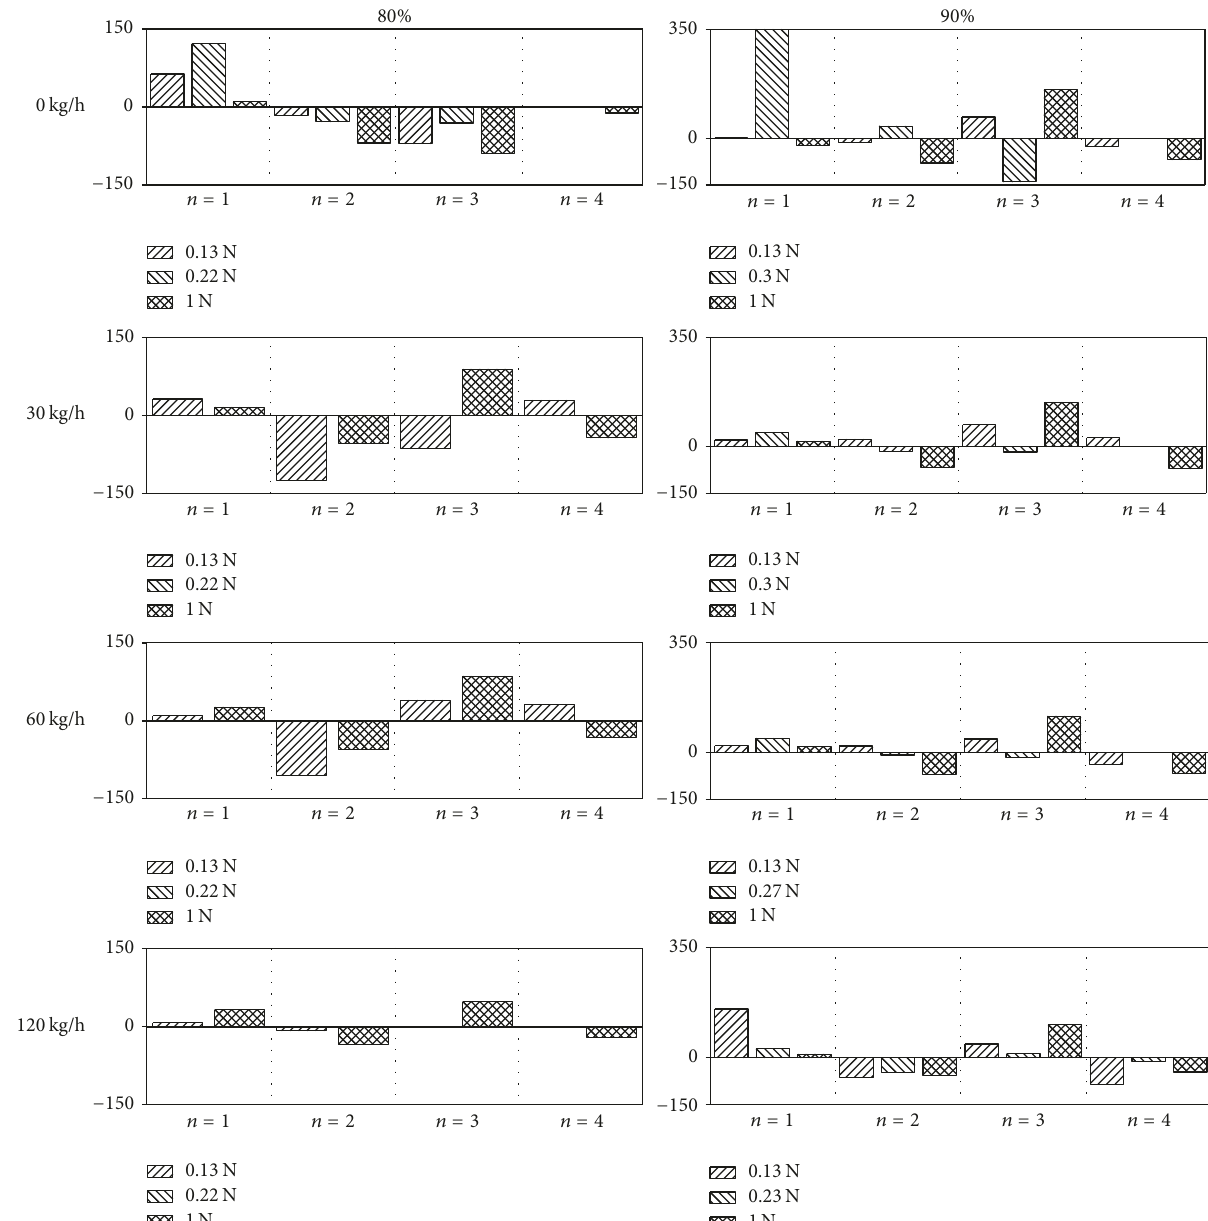
Figure 13: Harmonic content of traveling energy of the first four prestall modes at the diffuser inlet.